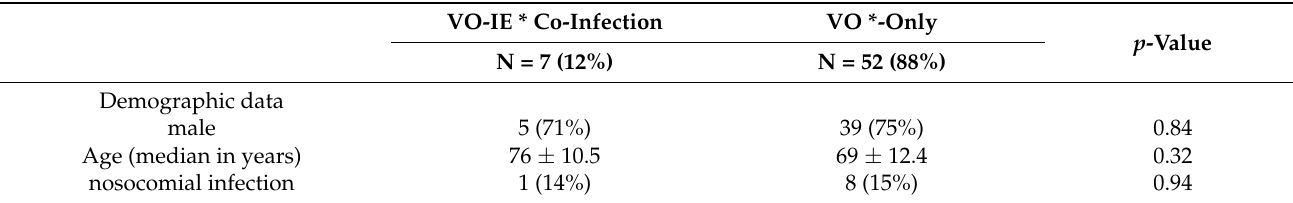
Table 2. Baseline characteristics of the VO-IE co-infection and VO-only groups. VO-IE *